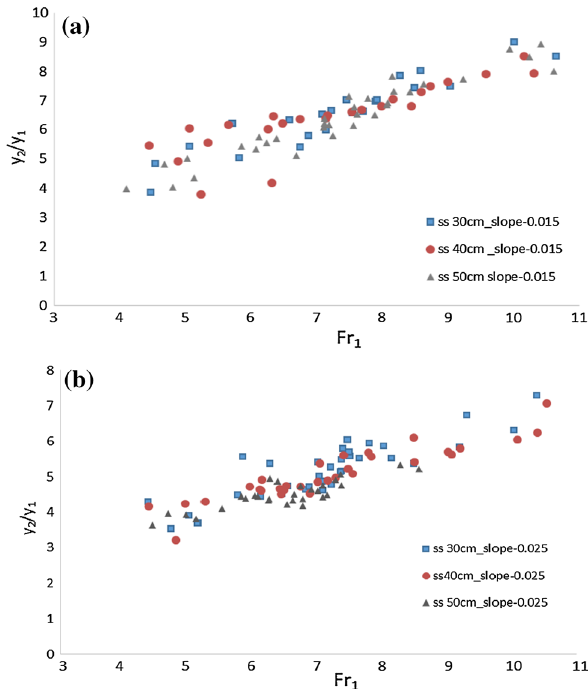
Fig. 2 Sequent depth ratio y single screen with different distances a S 0 = 0.015 b S 0 = 0.025)